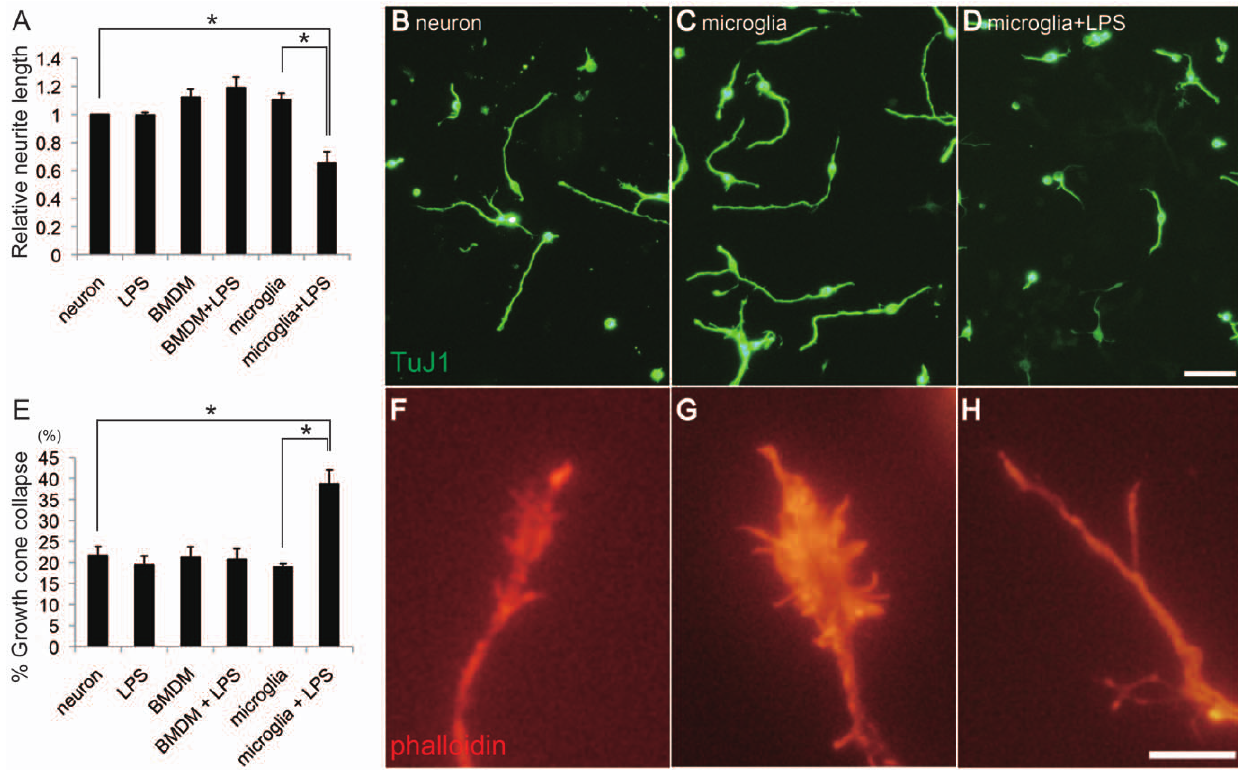
Figure 2. Activated microglia inhibit neurite outgrowth and induce growth cone collapse in vitro. A , Relative length of neurites of cortical neurons, neurons stimulated by LPS, and neurons co-cultured with BMDM, BMDM stimulated by LPS, microglia, or activated microglia stimulated by LPS (n=3). B – D , Representative figures of neurons (TuJ1, green, B ), neurons co-cultured with unactivated microglia ( C ), and neurons co- cultured with activated microglia ( D ). Scale bar: 20 m m. E , Collapse assay (n=3). F – H , Representative figures of growth cones (phalloidin staining, red) of a neuron ( F ), a neuron co-cultured with unactivated microglia ( G ), and a neuron co-cultured with activated microglia ( H ). Scale bar: 10 m m. Data are represented as mean 6 SEM. * p , 0.01 (one-way ANOVA followed by Tukey-Kramer test).